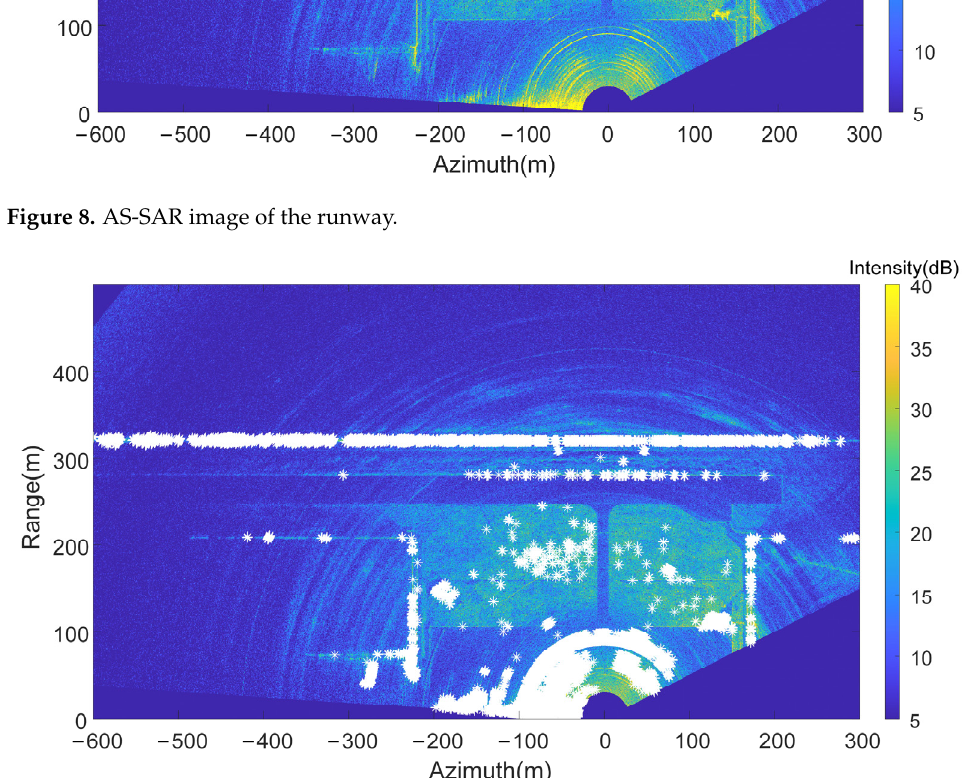
Figure 9. The screening results of SPCPs.